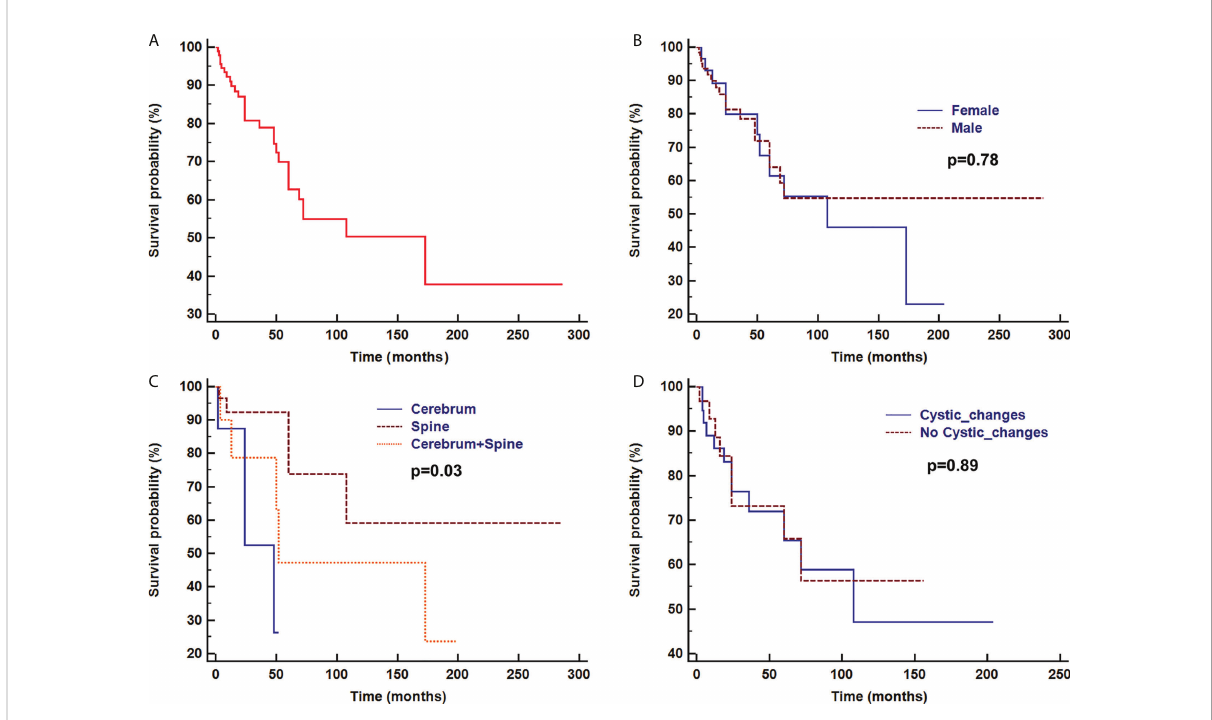
FIGURE 6 Survival curve analysis of overall survival (A) , sex (B) , and radiological fi ndings of parenchymal tumor location (C) , and with or without cystic changes (D) were analyzed using Kaplan – Meier curves and log-rank